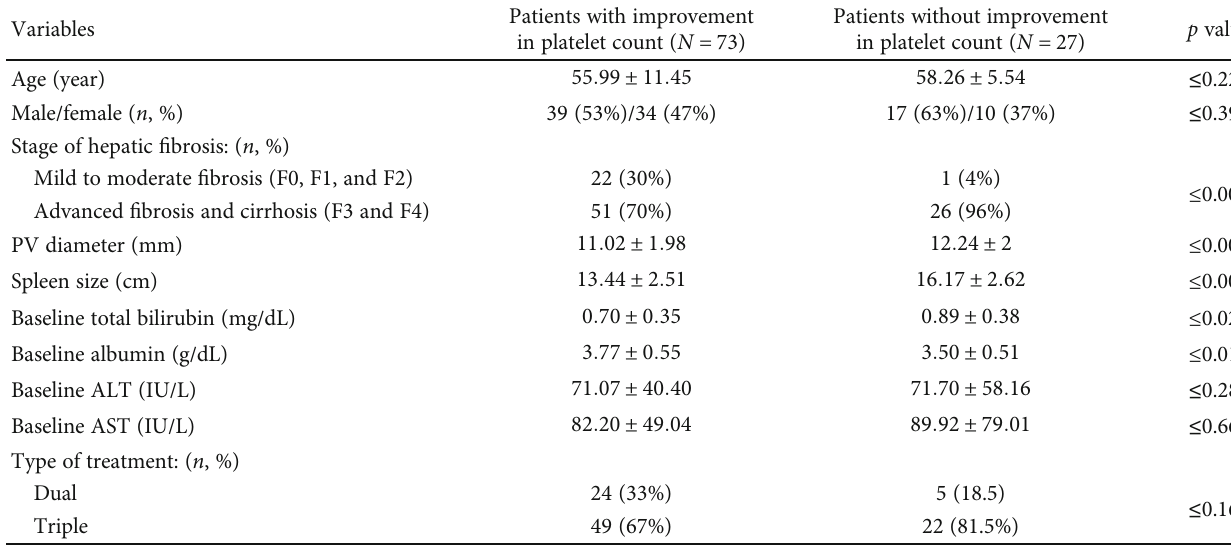
Table 6: Patients with and without improvement of platelet count at EOT.